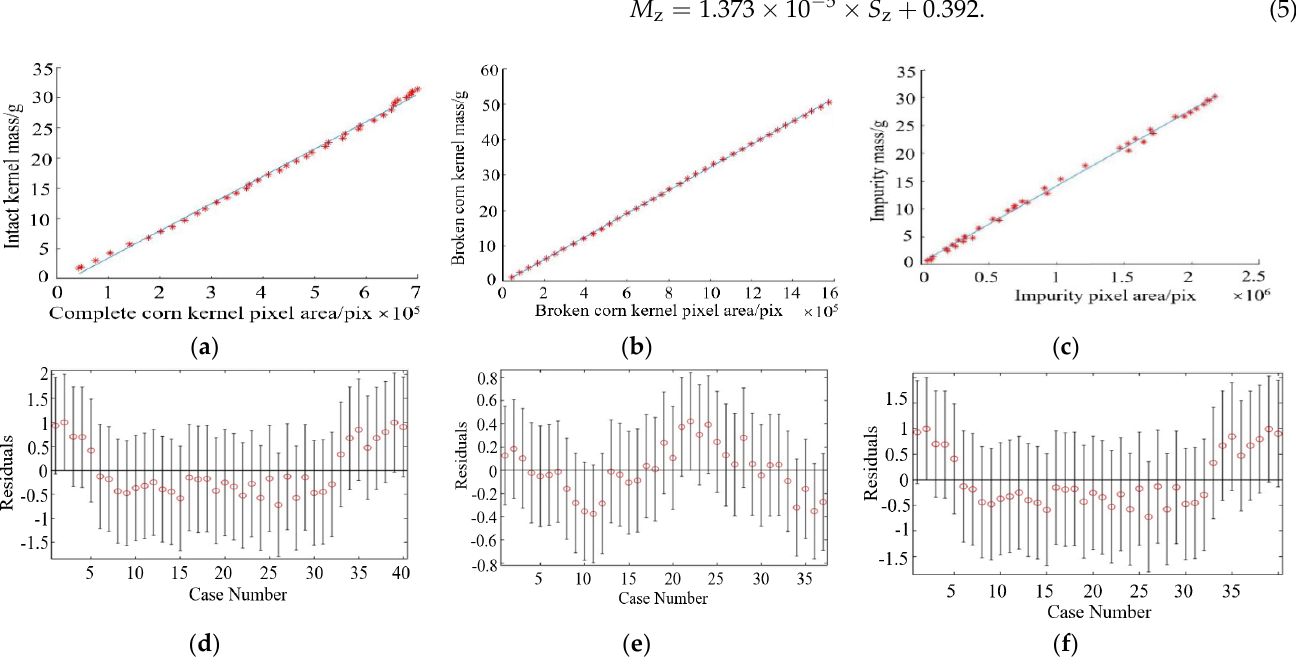
Figure 7. Linear regression analysis of pixel area and mass. ( a ) Relationship between the quality of the whole corn kernel and the pixel area, ( b ) relationship between broken corn kernel quality and pixel area ( c ) relationship between impurity quality and pixel area, ( d ) residual analysis of intact corn mass and pixel area, ( e ) residual analysis of broken corn quality and pixel area, and ( f ) residual analysis of impurity mass and pixel area.